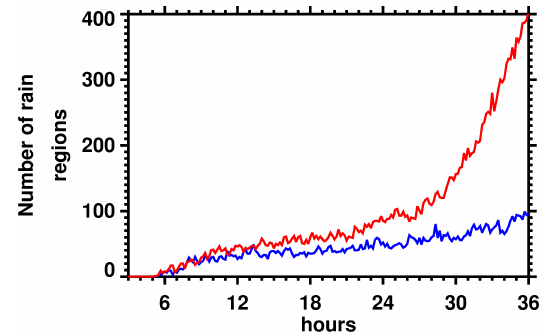
Fig. 14. Temporal evolution of the number of rain regions ≥ 1km 2 , with a surface rain rate ≥ 1mmd − 1 , in simulation S ◦ (blue) and S ⊗ (red).